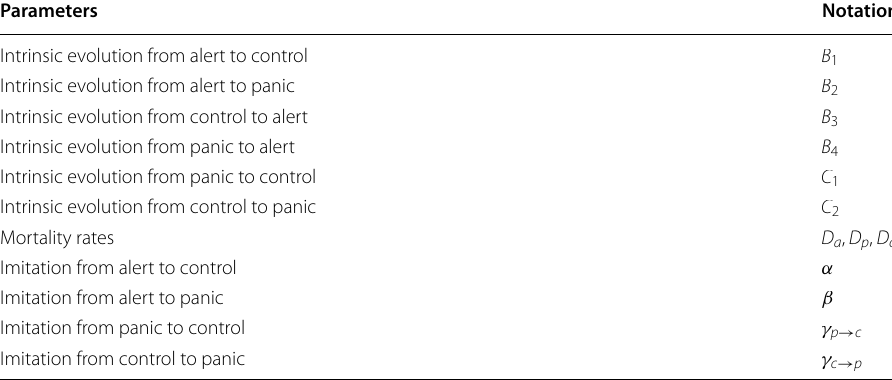
Table 3 Parameters of the APC